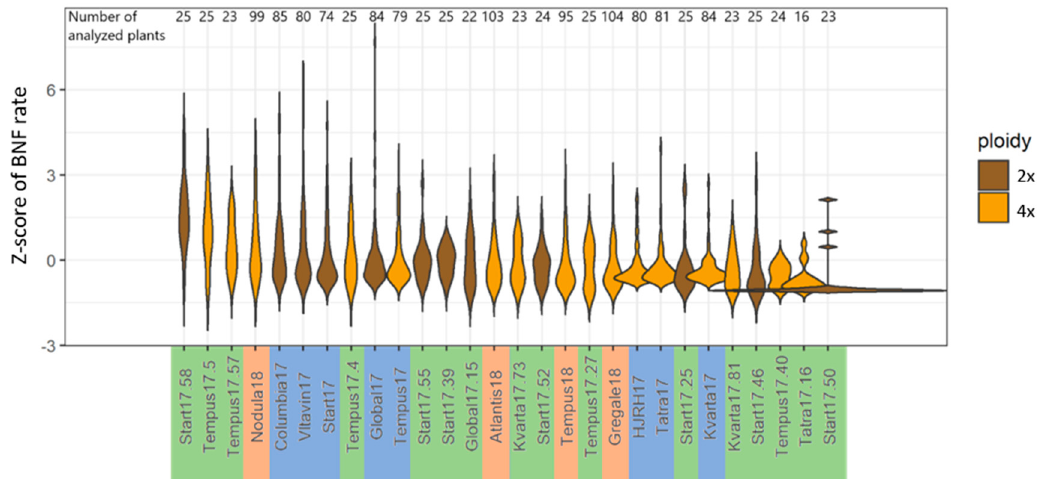
Figure 1. Distribution of Z -score for nitrogen fixation rate evaluated in red clover plants using acetylene reduction assay. On the x -axis, genotypes are ordered by mean values of nitrogen fixation. Diploid (brown) and tetraploid (yellow) red clover plants were measured in three sets: Set 1 (blue labels with suffix 17), Set 2 (orange labels, suffix 18), and Set 3 (green labels, suffix 17.xx—progeny of selected contrasting plants from Set 1).